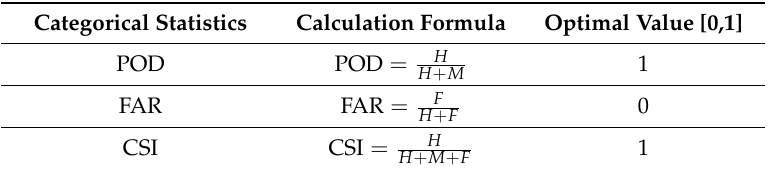
Table 2. Categorical metrics of detection capability.